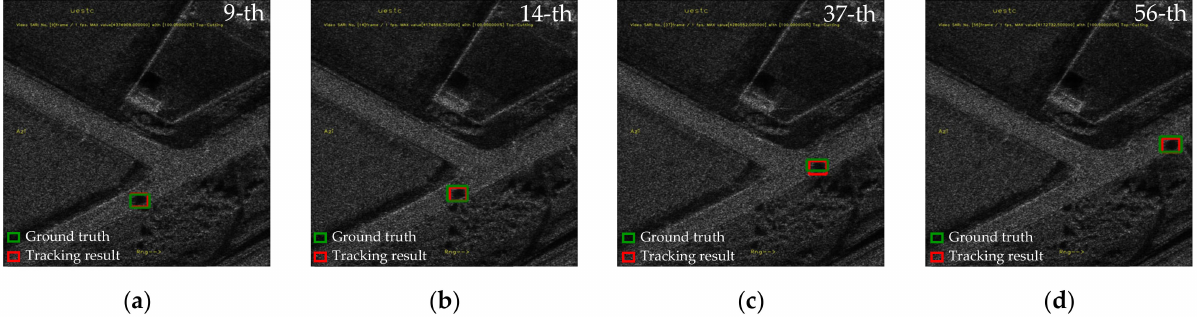
Figure 12. Tracking results of the simulated Video-SAR data: ( a ) 9th frame in Video 2; ( b ) 14th frame in Video 2; ( c ) 37th frame in Video 2; ( d ) 56th frame in Video